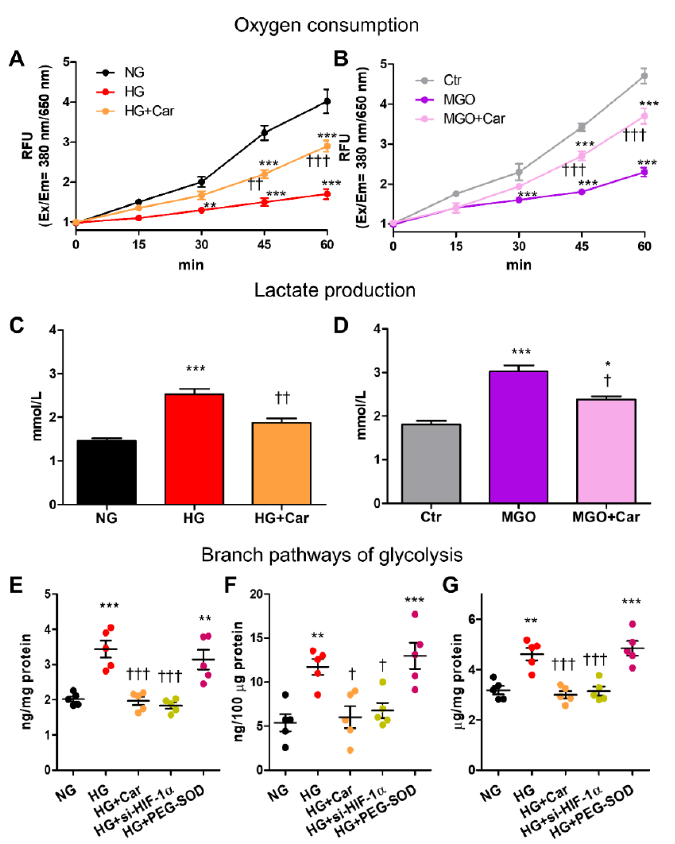
Figure 6. HG and the glycolytic side product MGO induce cellular energetic changes that resemble the Warburg effect and are associated with the activation of the alternative pathological pathways of glucose metabolism in HG conditions. Time course of oxygen consumption ( A , B ) and lactate production at 48 h ( C , D ) by HUVEC exposed to HG (20 mM) vs. NG (5.5 mM) ( A , C ), or treated with MGO (200 µM) vs. untreated cells (Ctr) ( B , D ), with or without the carbonyl trapping agent Car (20 mM); n = 3 separate experiments in duplicate per condition. Hexosamine ( E ), polyol ( F ) and AGE ( G ) pathways activation in HUVEC exposed to HG vs. NG for 48 h, with or without Car, as determined by measuring the levels of GFPT1 ( E ), D-sorbitol ( F ), and AGEs ( G ); each dot represents the mean of two technical replicates of 5 wells per condition. Bars represent mean ± SEM. Post hoc multiple comparison: *** p < 0.001, ** p < 0.01 or * p < 0.05 vs. NG or Ctr (as appropriate); ††† p < 0.001, †† p < 0.01 or † p < 0.05 vs. HG or MGO (as appropriate).